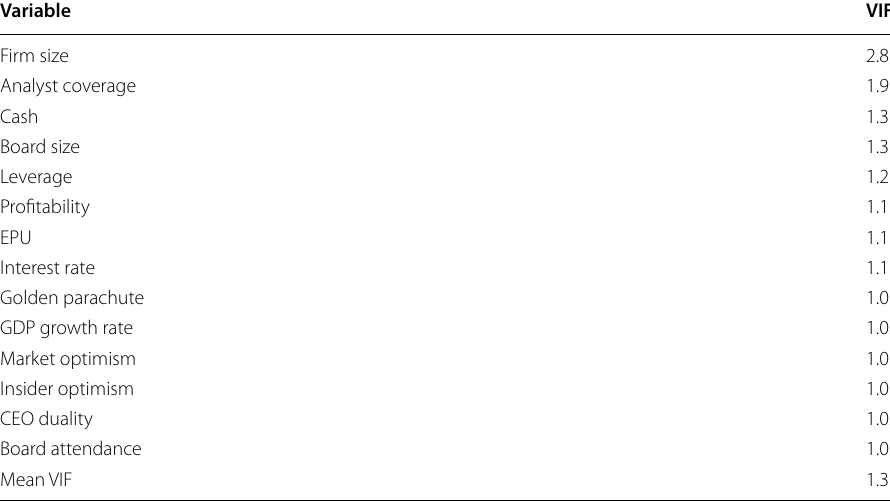
The table includes variables on governance, information asymmetry, and firm-specific factors. The sample selection model does not include firm ownership variables in the first equation on capital issuance and, consequently, are excluded from